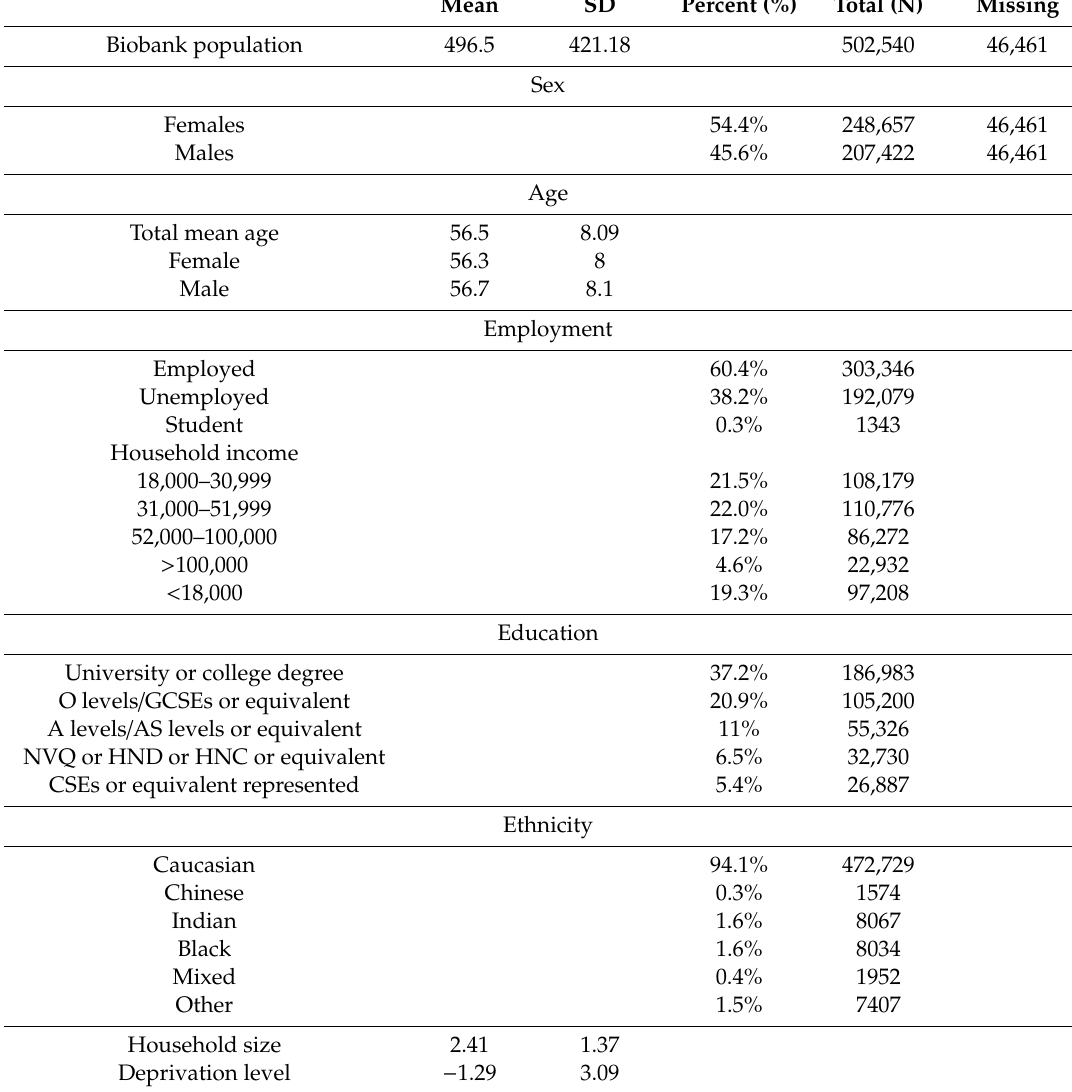
Table 1. Descriptive characteristics of